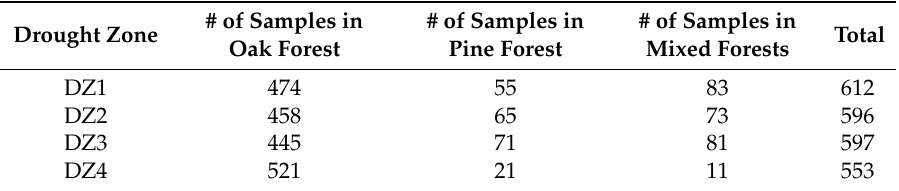
Table 2. The number of samples in each drought zone.